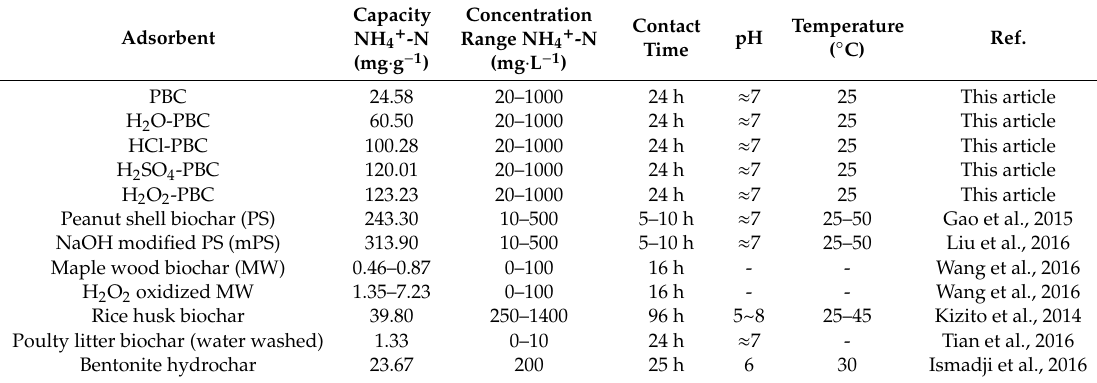
Table 4. Comparison of the maximum ammonium adsorption capacity onto various adsorbents.